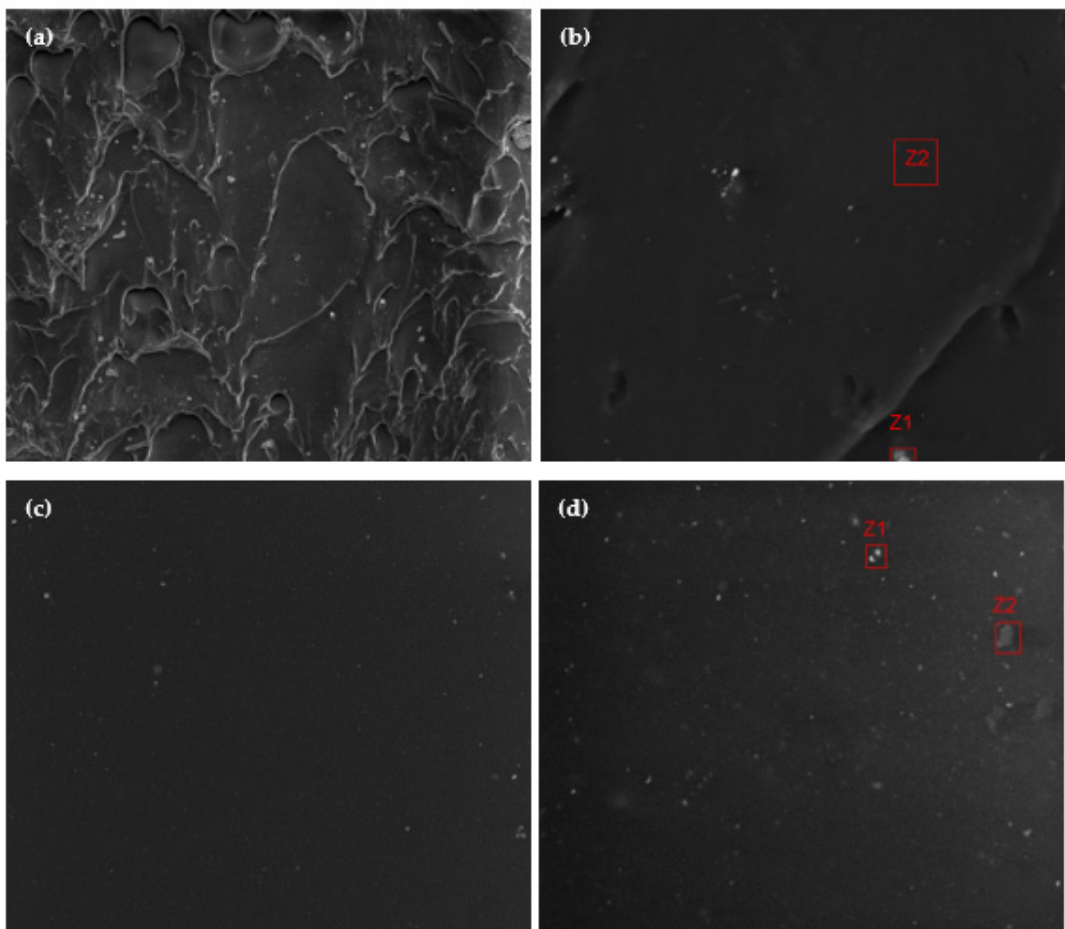
Figure 6. SEM images of: ( a ) polyurea A surface (magnification of 1000×), ( b ) highlighted zones on polyurea A surface (magnification of 5000×), ( c ) polyurea B surface (magnification of 1000×), ( d ) highlighted zones on polyurea B surface (magnification of 5000×).